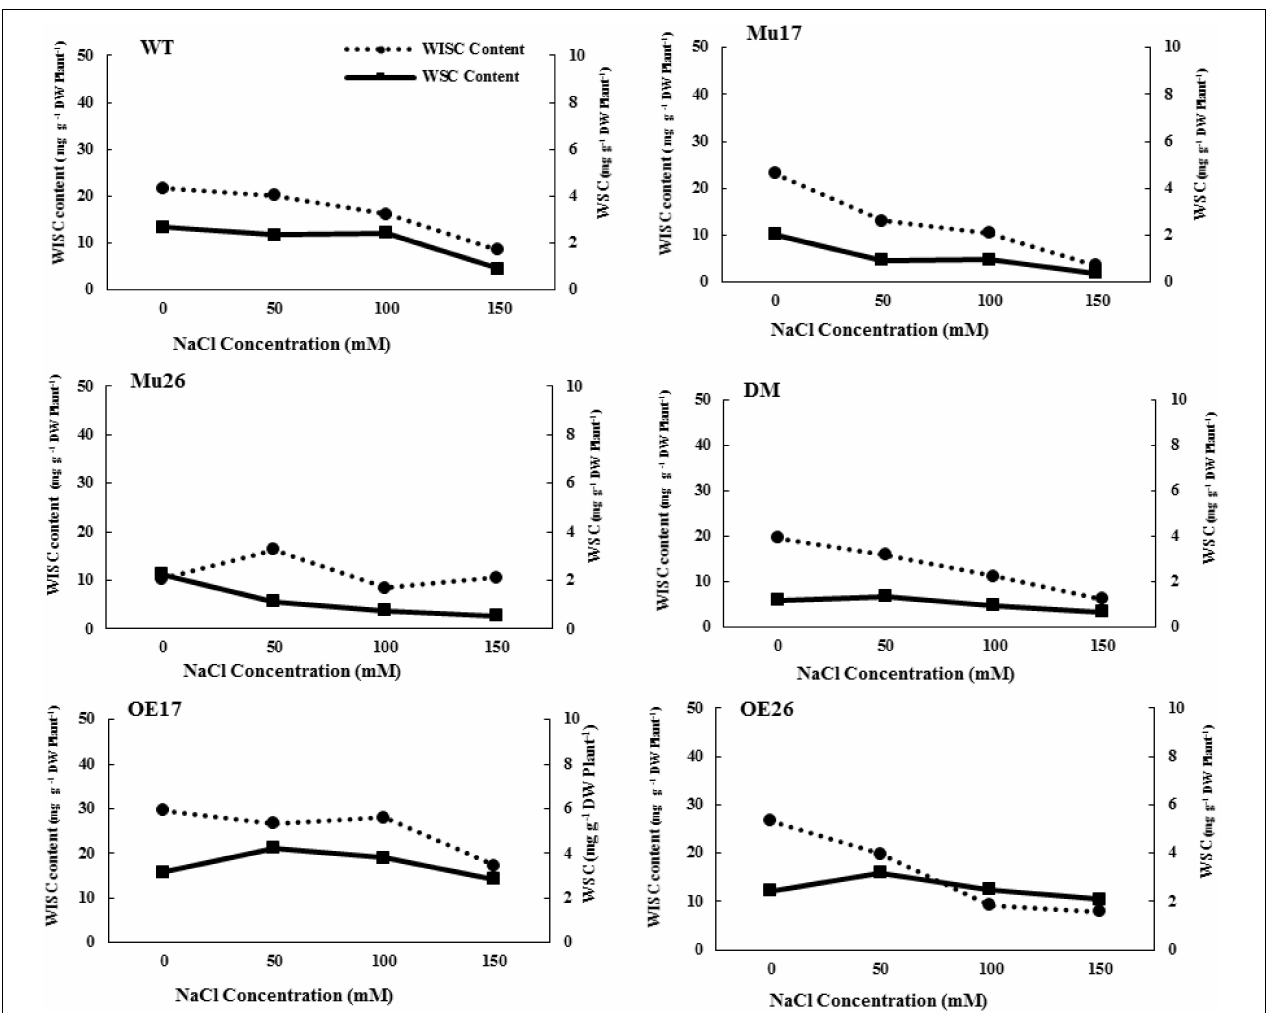
FIGURE 1 | Trend of water-soluble carbohydrate (WSC) and water-insoluble carbohydrate (WISC) on genotypes subjected to NaCl stress. Wild type (WT), overexpress (OE), single mutant (Mu) and double mutant (DM) genotypes of Arabidopsis thaliana purple acid phosphatase 17 ( AtPAP17 ) and 26 ( AtPAP26 ) genes.